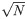
DNA Sudoku pooling example.In this example, there are a total of N = 96 samples. The 96-well plates show which samples are combined into each pool (Pi) for the two different window sizes (W1 = 10 and W2 = 11 which are greater than N and co-prime). By using two different window sizes, the weight of this pooling design is w = 2 meaning that k = w − 1 = 1 positive sample can be unambiguously identified in a single step using T = W1 + W2 = 21 tests. The positive samples are decoded by finding the samples that appear most often in the positive pools. For example, if G10 is the only positive sample, we can detect this from the pooling results by noticing that G10 was added to both of the positive (red) pools while the other samples in those pools were added to only one or the other. Alternatively, if both G10 and D4 are positive, four samples occur with equal frequency (D4, G10, E12, and F2) in the positive pools (red and purple) and it is impossible to determine which are the true positive samples. This ambiguity is introduced because the test was designed to handle only one positive sample.